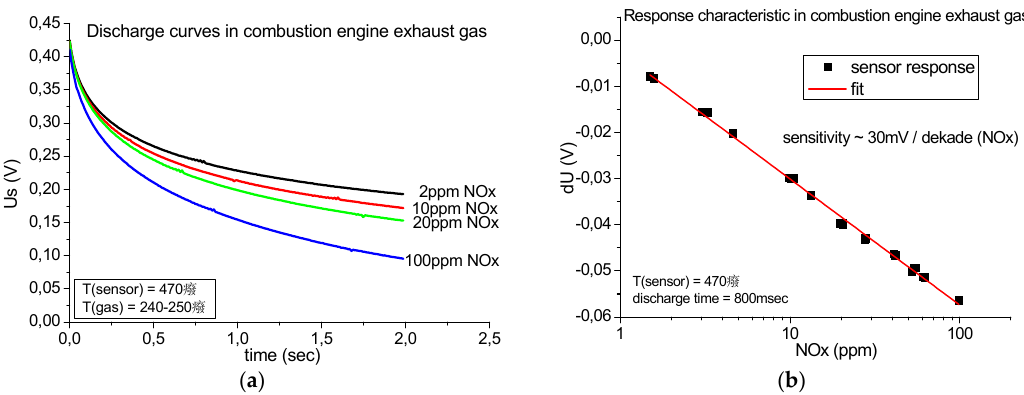
Figure 2. ( a ) discharge curves at varying NOx concentrations in diesel exhaust gas; ( b ) Sensor response derived from discharge curves at NO concentrations from 2 ppm to 50 ppm. dU corresponds to the change in sensor voltage after 800 ms discharge time.